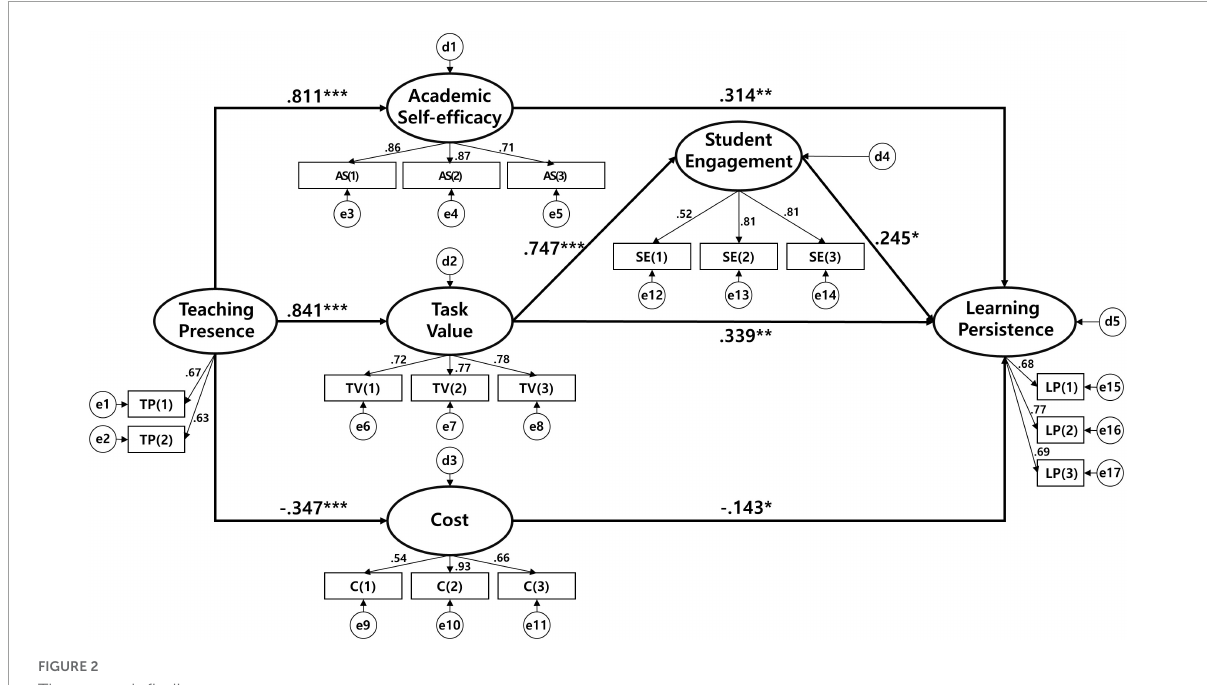
FIGURE2 The research